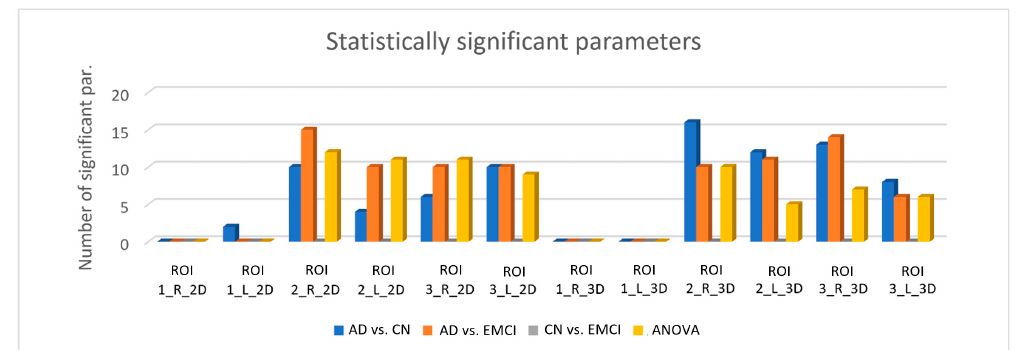
Figure 3. Number of values that turned out to be significant ( p < 0.05) for each ROI with MWW and ANOVA tests and BH correction. ROI1, ROI2 and ROI3 refer to the ROIs with r = 3, 5 and 8 pixels respectively. The suffixes “R” and “L” correspond to those ROIs placed on the right and left hippocampus respectively. The suffixes “2D” and “3D” refer to circular and spherical ROIs respectively.